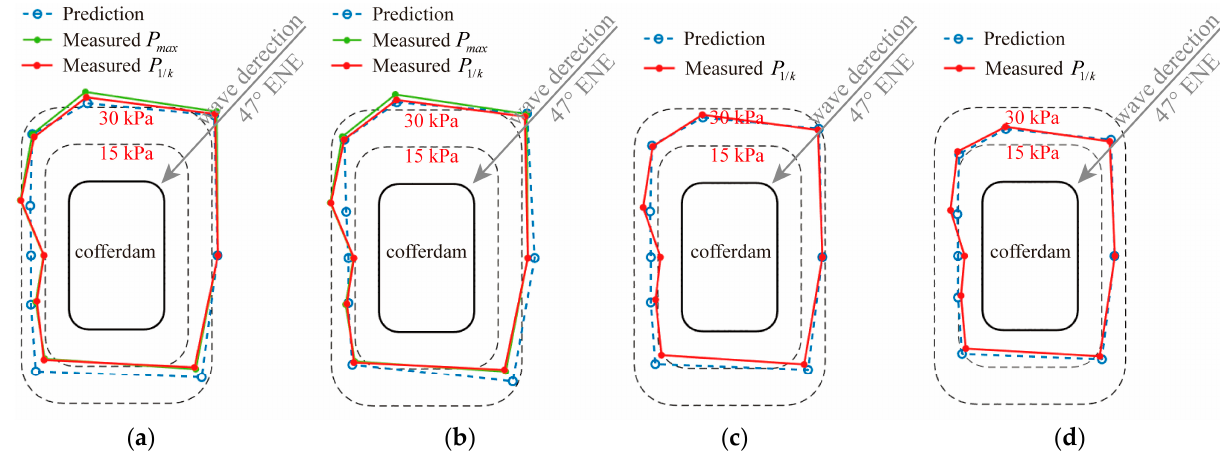
Figure 11. Pressure spatial distributions at − 2.37 m. ( a ) H 1/100 , T 1/100 ( b ) H 1/100 , T m ( c ) H 1/10 , T 1/10